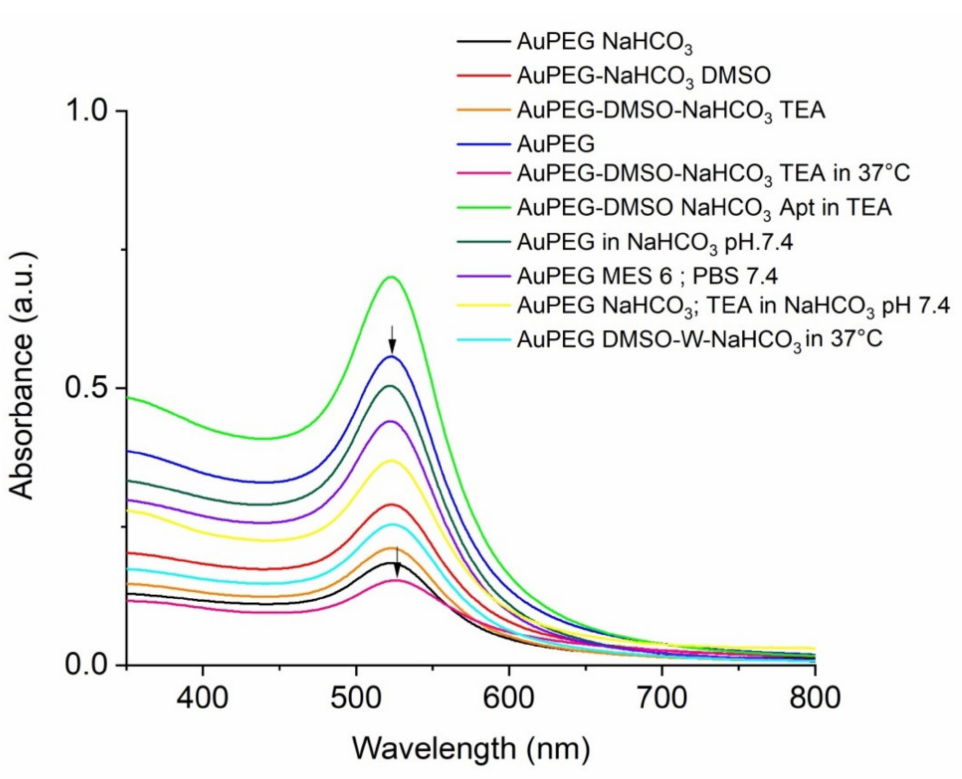
Figure 2. The results of different protocols were used for conjugating CD133 aptamer to Au-PEG-COOH. These graphs have demonstrated different wavelengths of all reactions and one shifting to the right in one of the reactions compared to Au-PEG as our control. This shifting has shown the covalent reaction which happened to the nanoparticle after conjugating with the CD133